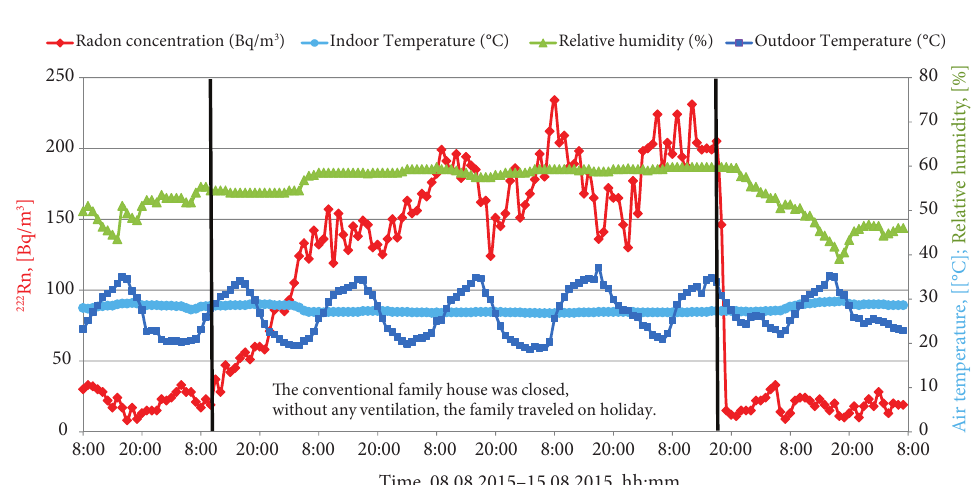
Figure 6. Indoor radon concentration in 2015 summer at Gö1